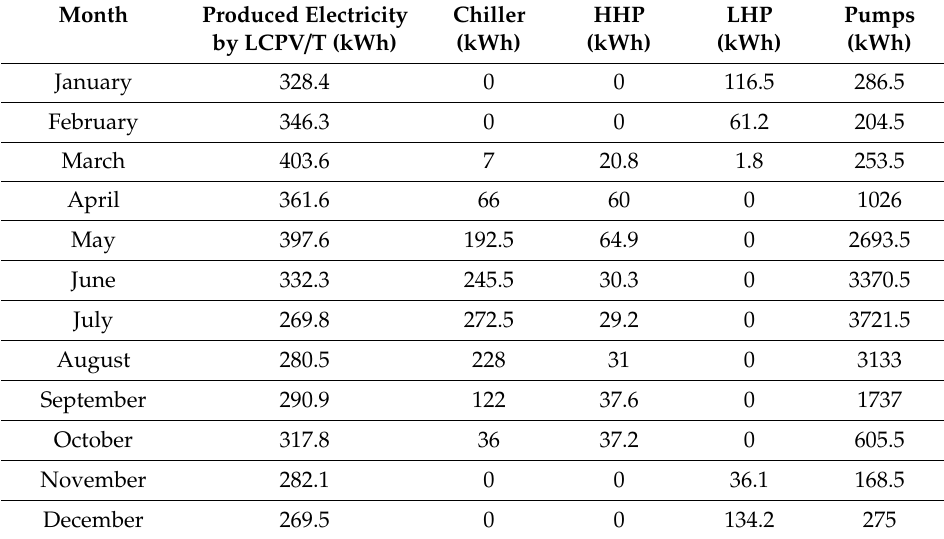
Chiller HHP LHP Pumps (kWh) (kWh) (kWh) (kWh)